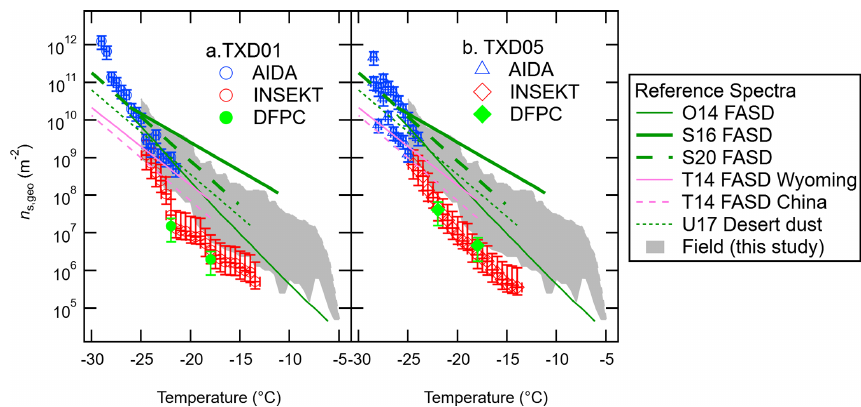
Figure 4. IN-active surface-site density, n s , geo , of surface materials, TXD01 (a) and TXD05 (b) , was assessed by AIDA, INSEKT, and DFPC (total aerosol particles) as a function of temperature. Six reference n s , geo curves for fertile and agricultural soil dust (FASD) and desert dust are adapted from O’Sullivan et al. (2014; O14), Steinke et al. (2016; S16), Steinke et al. (2020; S20), Ullrich et al. (2017; U17), and Tobo et al. (2014; T14). The grey-shaded area represents the range of our field n s , geo values at a 0.5 ◦ C interval for − 5 ◦ C > temperature > − 25 ◦ C (Fig. 8). Table 5. DFPC-estimated n INP for TXD01 and TXD05 samples. The subscripts of Tot and PM 1 represent INP obtained from total aerosol particles and that from PM 1 size-segregated aerosol particles, respectively. Standard deviations were derived based on multiple measurements for each